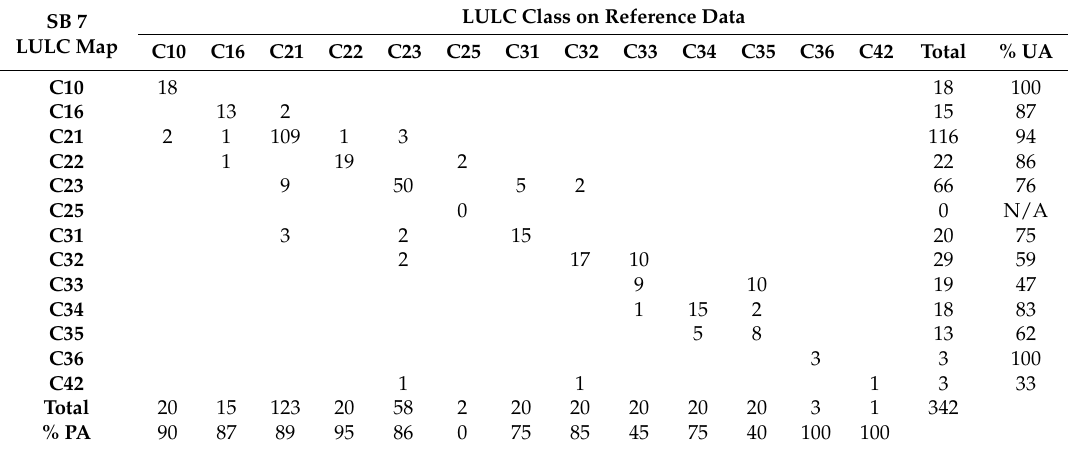
Table 3. SB7 LULC map error matrix at full scheme specificity for 342 total sample locations (PA = Producer Agreement and UA = User Agreement).